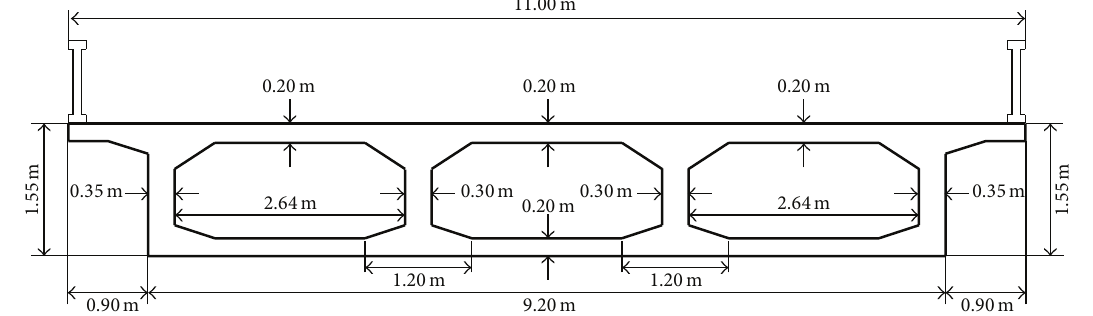
Figure 5: Cross-sectional configurations and dimensions of the considered